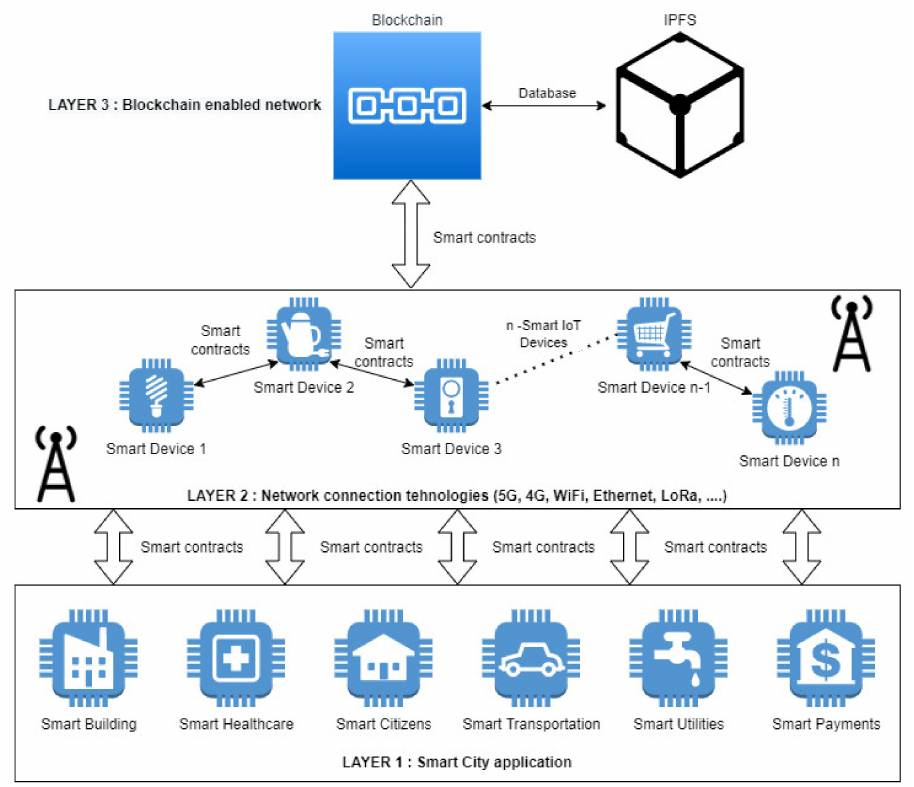
Figure 6. The blockchain solution for Smart City.